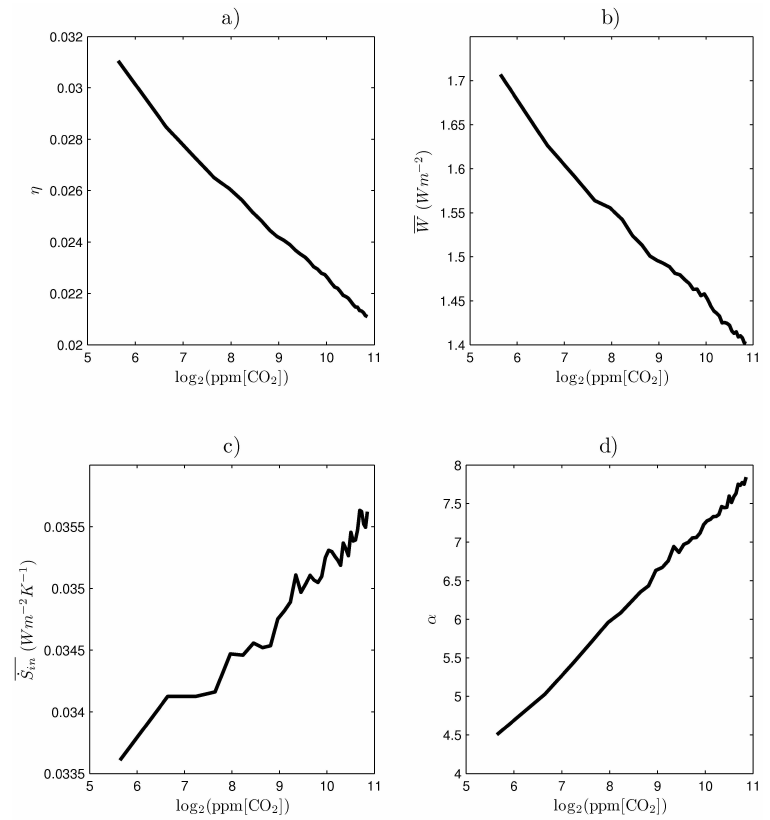
Fig. 2. Generalised climate sensitivities. CO 2 concentration dependence of macroscopic thermodynamic variables: (a) efficiency; (b) intensity of the Lorenz energy cycle (or, equivalently, total dissipation); (c) material entropy production; (d) degree of irreversibility. See text for